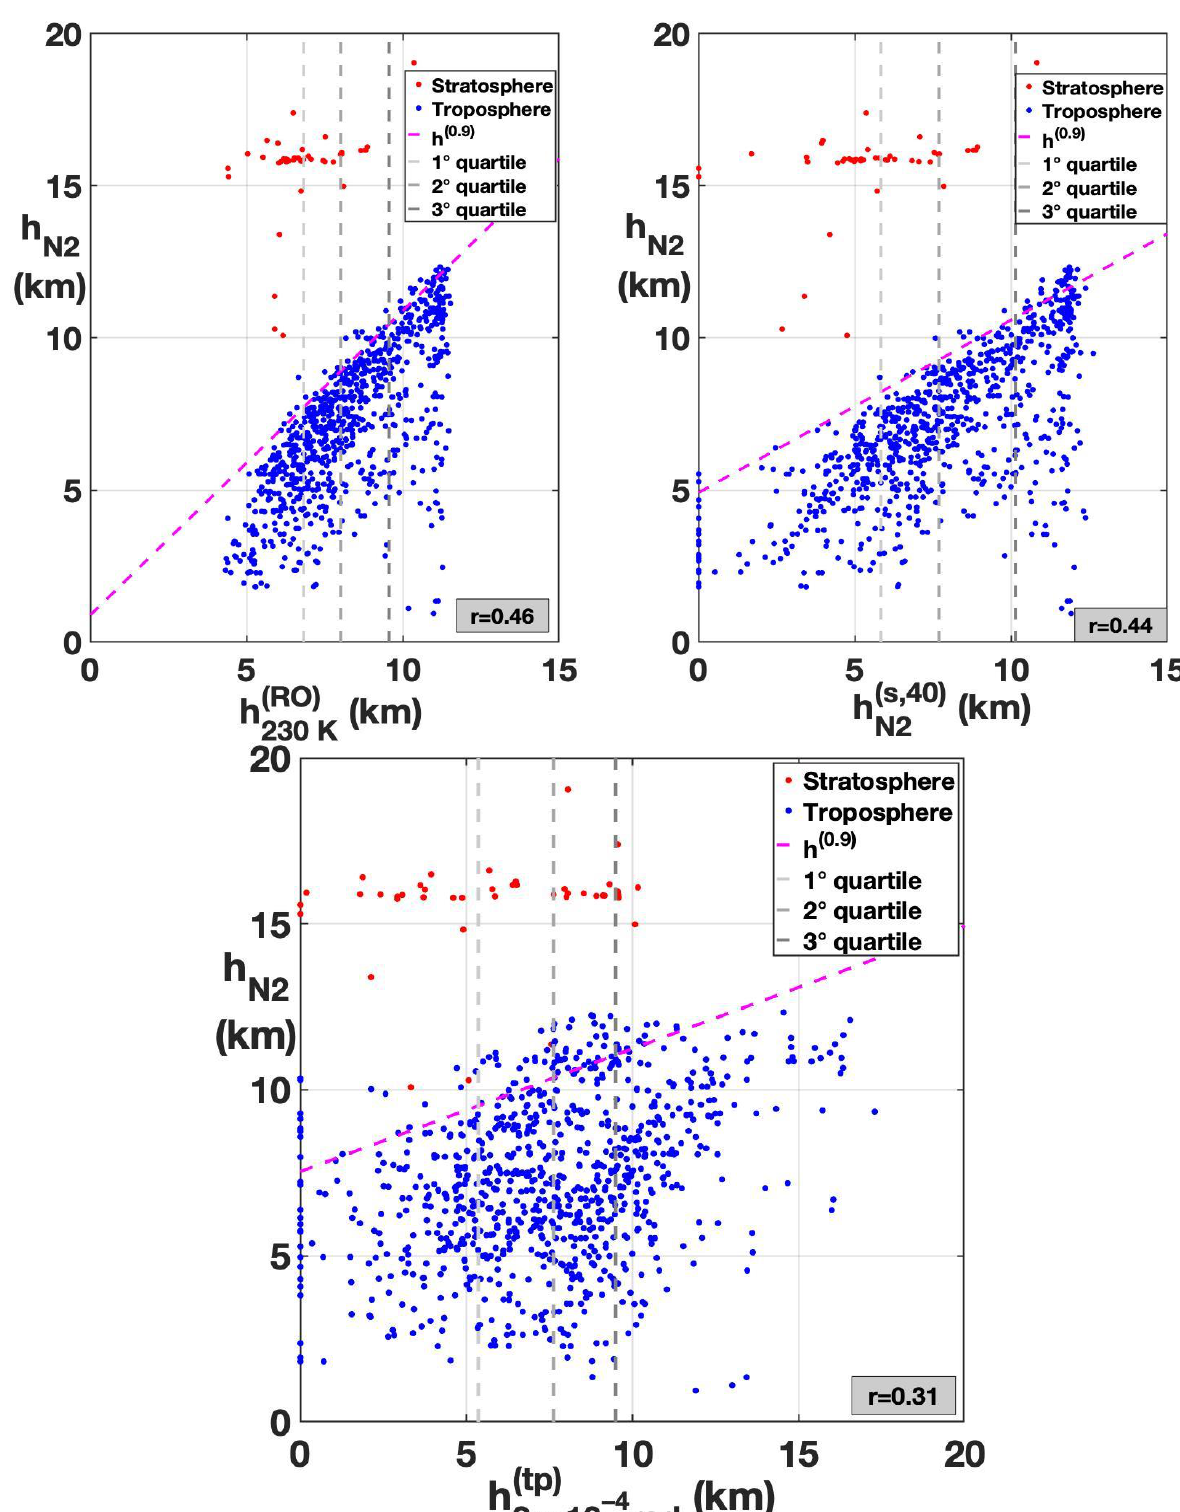
( RO ) ( top left ), 230 K